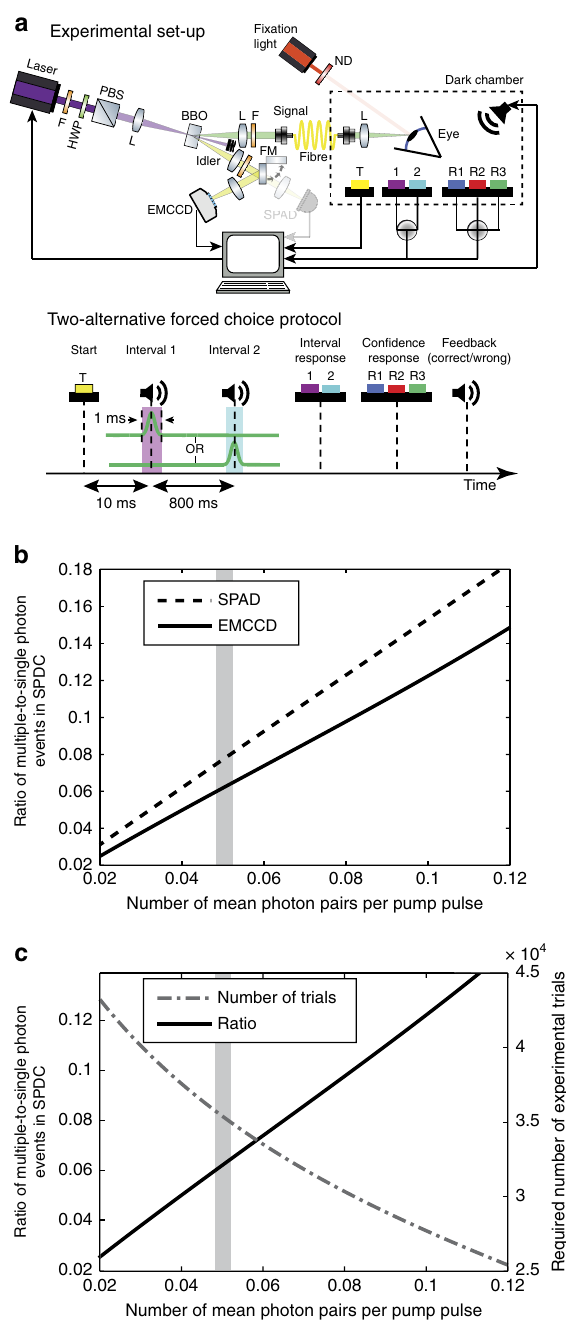
Figure 1 | Schematics of the experimental set-up and characterization of the single photon quantum-optical light source. ( a ) Top: schematic of the set-up for generating single photons via SPDC. Light stimuli are triggered (T) by subjects and coupled into a single-mode fibre entering the dark chamber. The light is directed and focused onto the pupil (Maxwellian view) at an angle of 23 (cid:2) temporal to a highly attenuated red fixation light presented at the fovea. BBO, beta-barium borate crystal; F, bandpass and spatial filter; HWP, half-wave-plate; L, lens; ND, neutral density filter; PBS, polarizing beamsplitter. A flip mirror (FM) allowed for the switching of the detection mechanism from the EMCCD to a SPAD (semi-transparent, see Methods section for details). Bottom: schematic of the 2AFC protocol. A 1ms light pulse is presented together with either the first or the second acoustic signal (intervals 1 and 2) that are separated by 800ms. After the second acoustic signal, the subject gives their answer (1, 2) and a confidence rating (R1, R2 and R3; see Methods section for details.) ( b ) Numerical simulation of multiple-to-single photon ratio in SPDC as a function of mean photon pairs per pulse (that is, at different pump laser intensities). While the multiple-to-single photon ratio decreases as a function of mean photon pairs for both detection schemes, the EMCCD (solid line) exhibits an improved multiple-to-single ratio compared with the SPAD (dotted line), as the multi-pixel based detection in case of EMCCD allows for identification and of two and multi-photon events and their rejection. ( c ) Trade-off between multiple-to-single photon ratio and required number of experimental trials. Multiple-to-single photon ratio in SPDC using EMCCD-based detection as a function of mean photon pairs per pulse (black solid line – same as in b ) exhibits an inverse relationship with the number of trials required to discriminate the performance of an ideal detector from random chance level (0.5) with a statistically significant probability (95% confidence interval; grey dotted line). The vertical grey bar indicates the mean number of photon pairs per pump pulse that was used in the experiments (see Methods section for